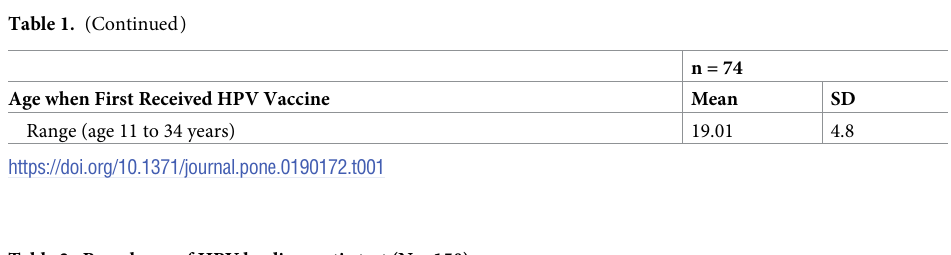
Table 2. Prevalence of HPV by diagnostic test (N =